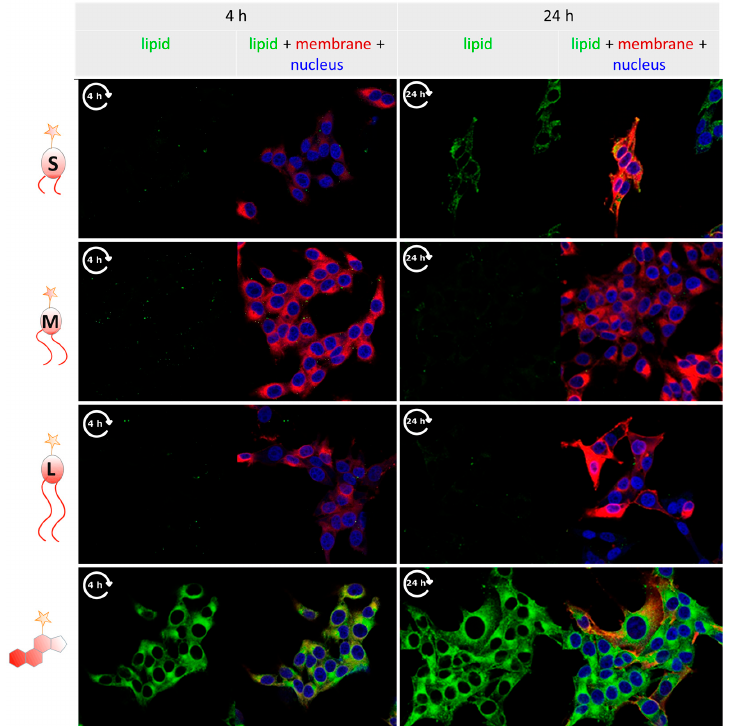
Figure 3. Confocal fluorescence imaging of UKRV-Mel-15a cells, observed at 4 h and 24 h after incubation with liposomes containing membrane label (DiD, red) and click-labeled experimental lipids with varied chain length (atto 488, green). Cell nuclei were stained with Hoechst (blue). Together with the cell membrane shown in red, the insertion of lipids becomes visible as an orange signal in the merge view.